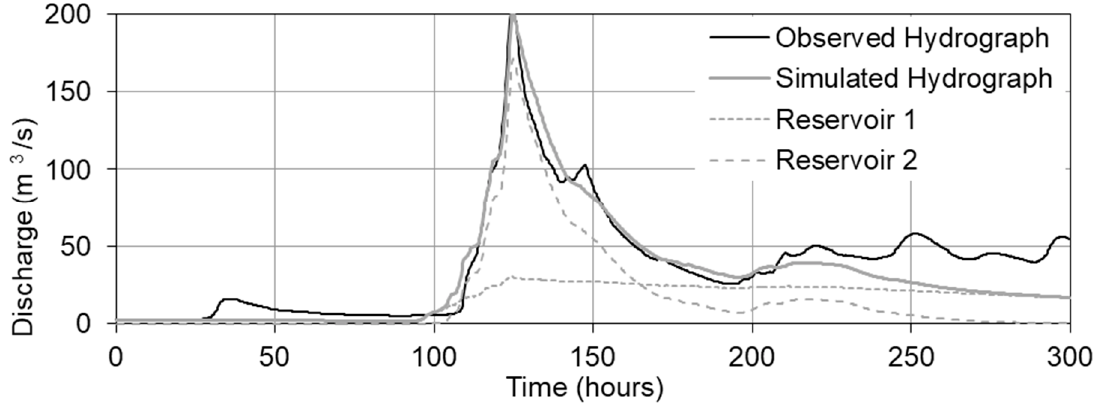
Figure 8. Simulated hydrograph considering snowmelt. Fragmented lines show the partial hydrographs for each reservoir.